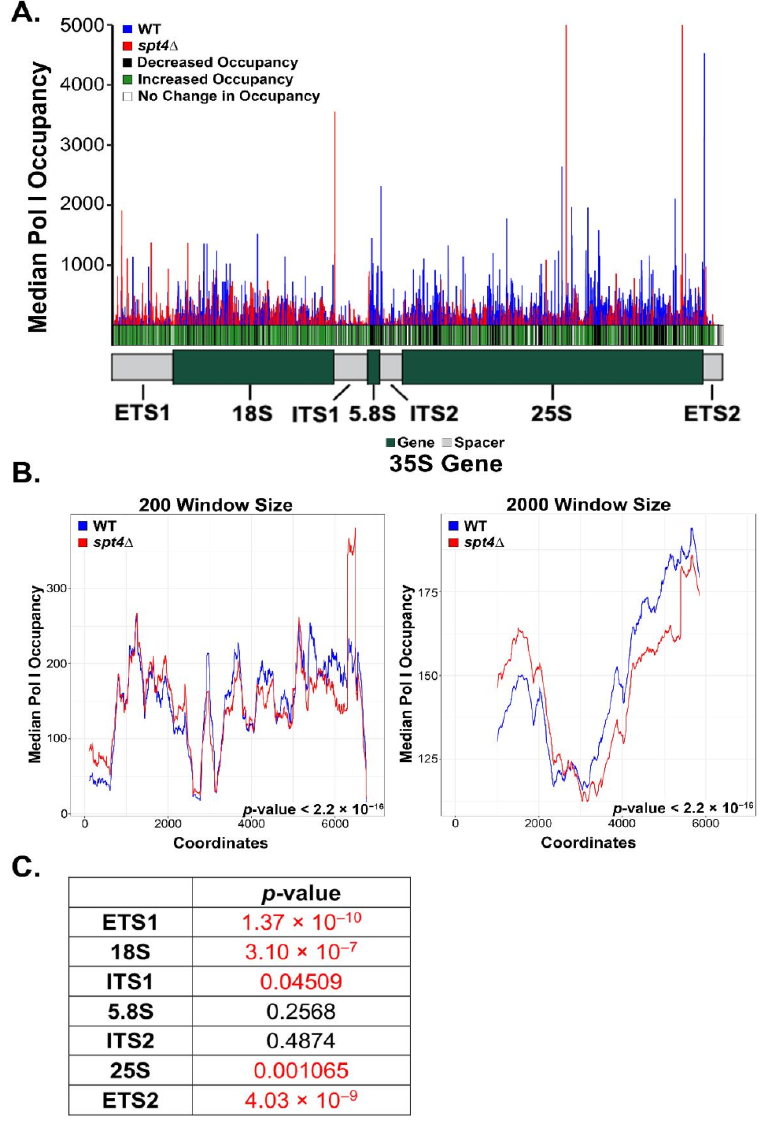
Figure 2. Spt4 promotes Pol I processivity during transcription of the rDNA. ( A ) The median occupancy of the three replicates for each strain was plotted. At each position, a p -value was calculated based on the occupancy of the WT vs. spt4 (cid:52) strains. If the occupancy in the spt4 (cid:52) strain was significantly increased compared to WT, that was deemed “increased occupancy”, and the same process was taken for the “decreased occupancy” positions. ( B ) The moving average was calculated for every x number of positions (where x is equivalent to window size; for the 200 window size, x = 200 and for the 2000 window size, x = 2000), and plotted. The Kolmogorov–Smirnov test was used to determine whether the two strains displayed the same or different distributions; p -values are included on the graphs. ( C ) The Kolmogorov–Smirnov statistical test was run for each region of the 35S gene to compare between the occupancy of the two strains. The p -value is indicated in the table for each